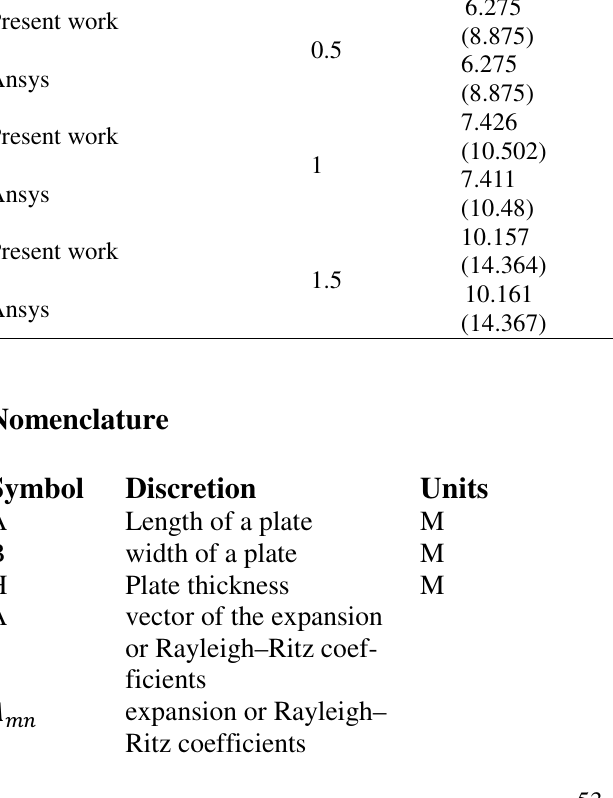
Dimensionless natural frequency , for [0 90 90 0] (SSSS) plates with effect of aspect and ² modulus ratios, ( (natural frequency without load) (cid:21)É4 = É Ê ¾ ËÌ ¯ ³ ² ⁄ ´⁄ (cid:24) º ·² = ¸. ½³ ² , ¼ ·² = ¸. ²½(cid:13)